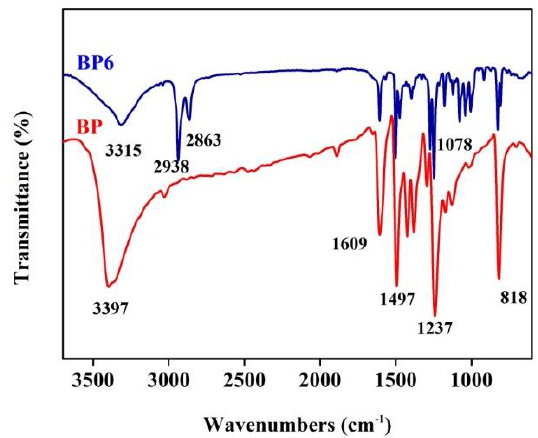
Figure 1. the Fourier-transform infrared spectroscopy (FTIR) spectra of BP and BP6.